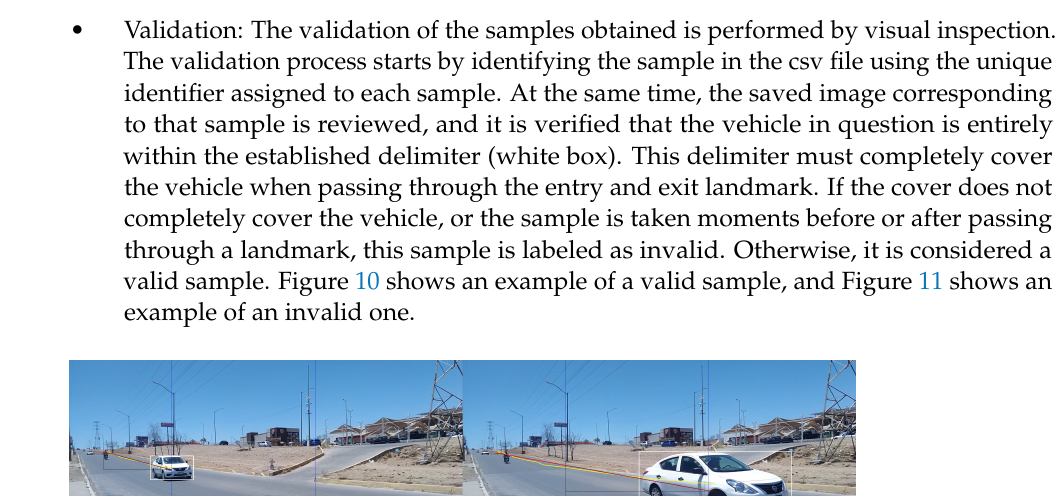
Figure 9. Vehicle identified and tracked.